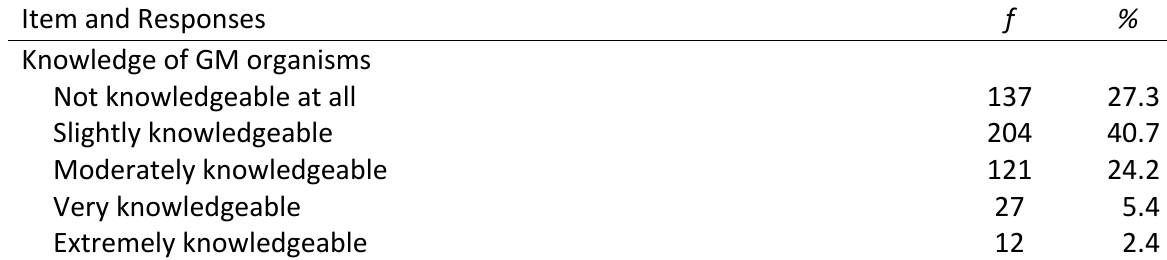
Frequency Distribution of Respondents’ Degree of Knowledge of GM and Organic Products Item and